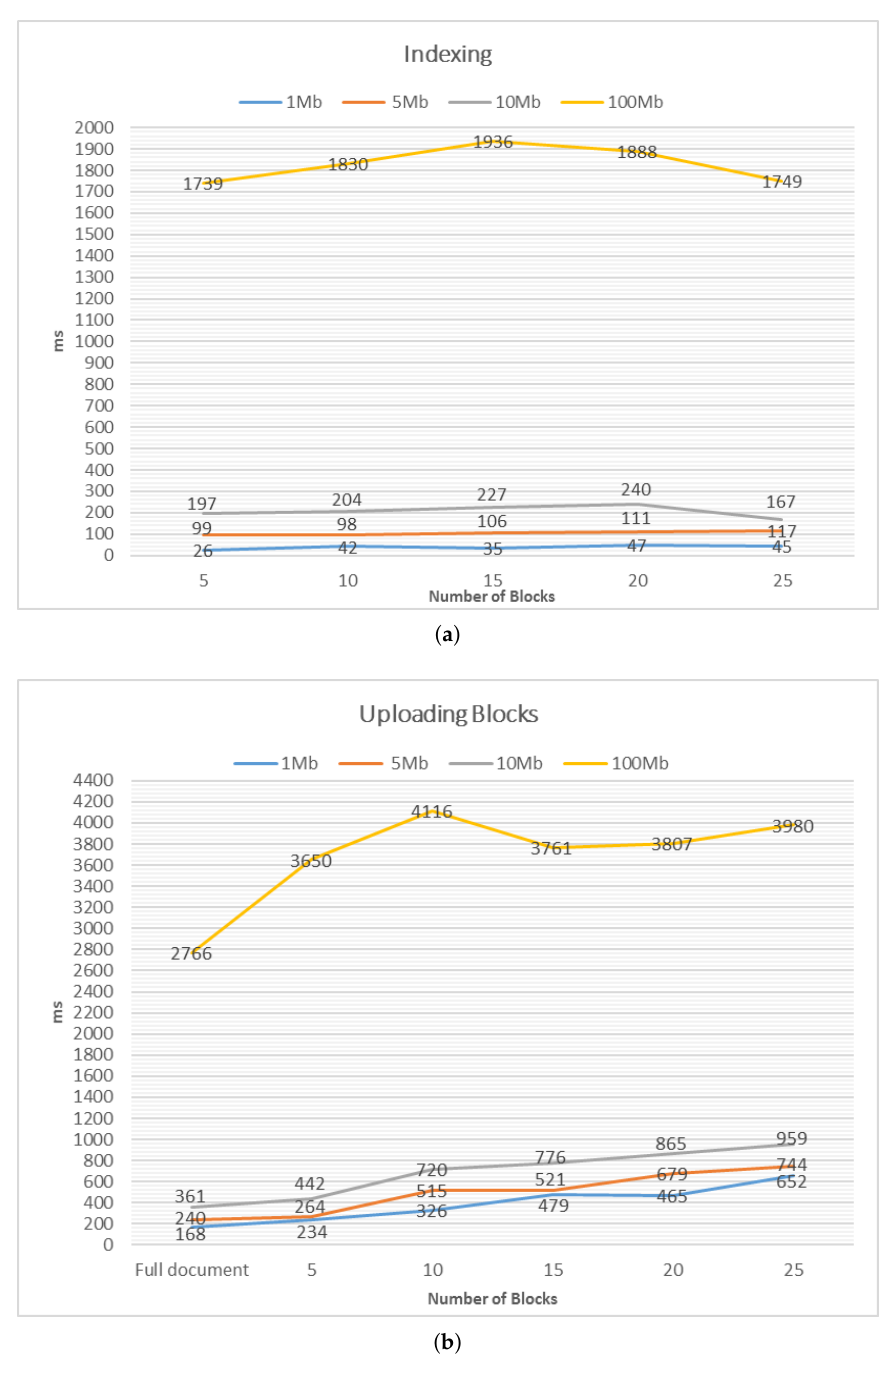
Figure 11. Performance results. ( a ) Indexing; ( b ) Uploading